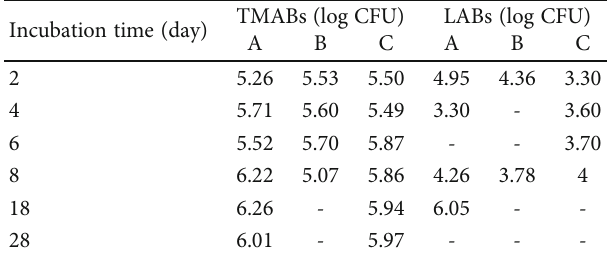
Table 3: TMAB and LABs of recipes A, B, and